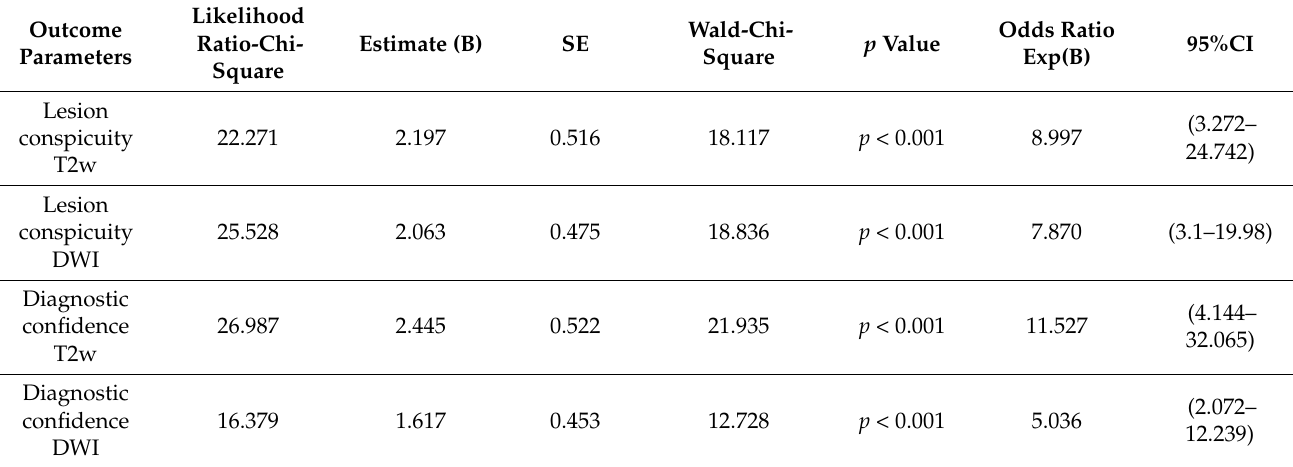
Table 5. Post-hoc logistic regression results for lesion conspicuity and diagnostic confidence in terms of reading the MRL images without MRI3T or in consensus with